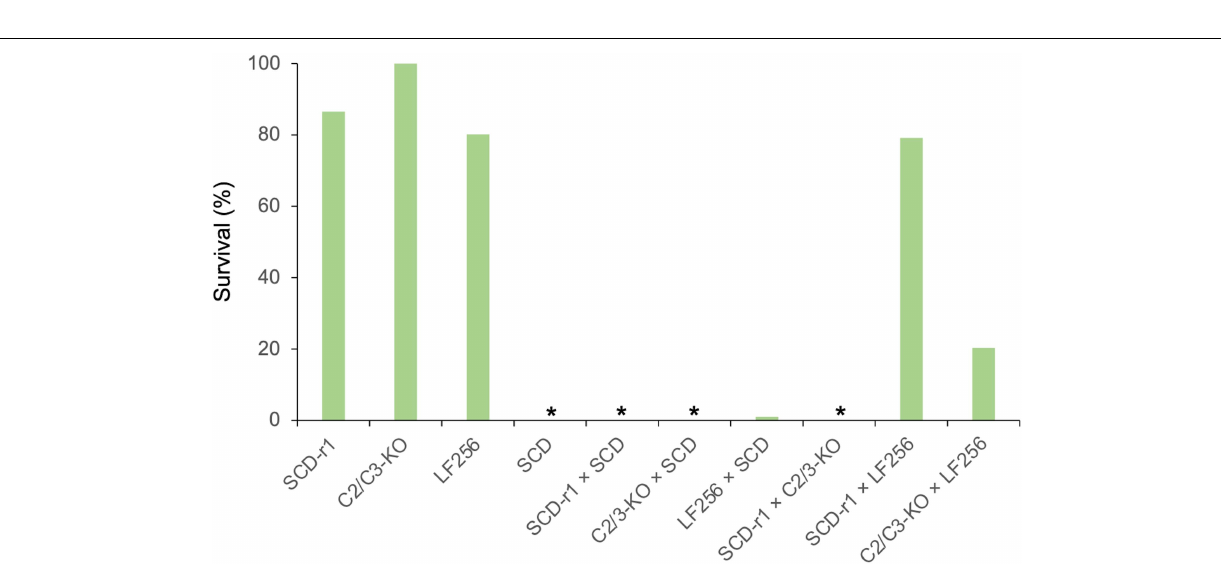
Frontiers in Microbiology |